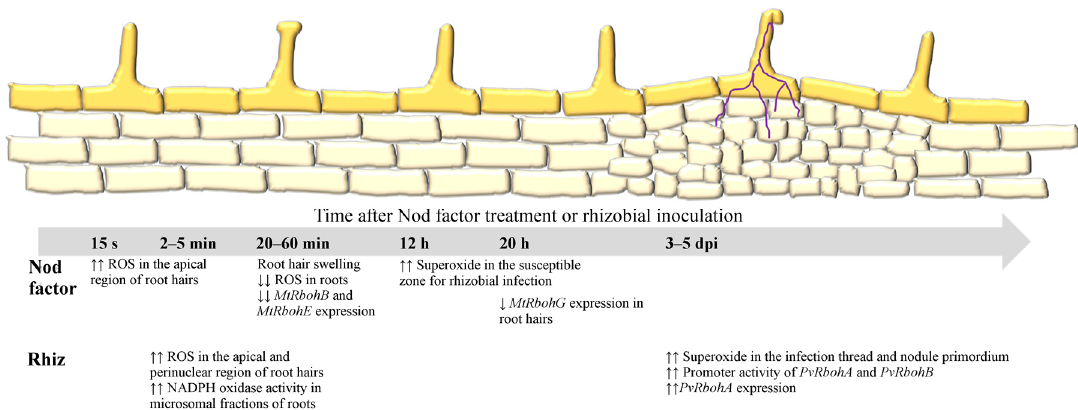
Figure 1. ROS levels and Rboh expression after Nod factor perception, rhizobial infection, and nodule primordium formation. The early stages of nodulation are illustrated along with the changes in ROS levels and Rboh expression after Nod factor treatment or rhizobial (Rhiz) inoculation. The purple line indicates the infection thread progression. The arrows indicate an increase ( ↑ ) and a decrease ( ↓ ) of ROS levels and Rboh expression.